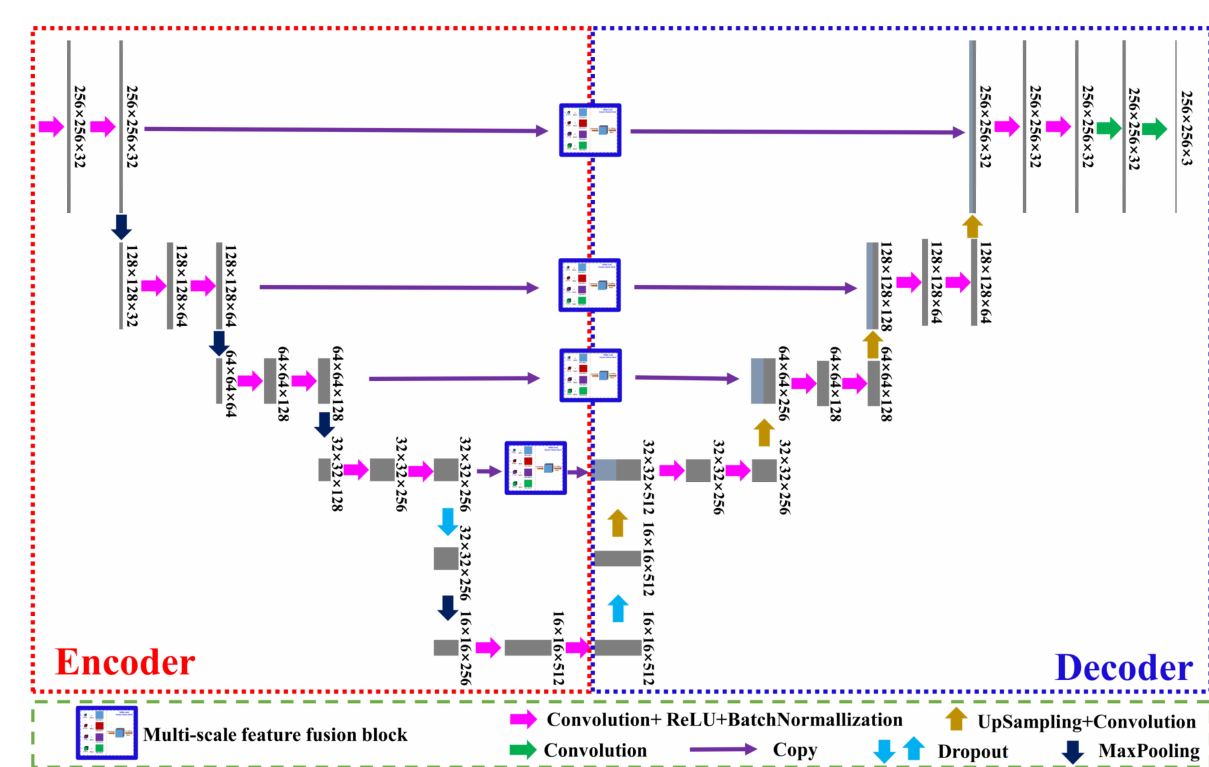
Figure 13. Multi-Scale U-Net1.